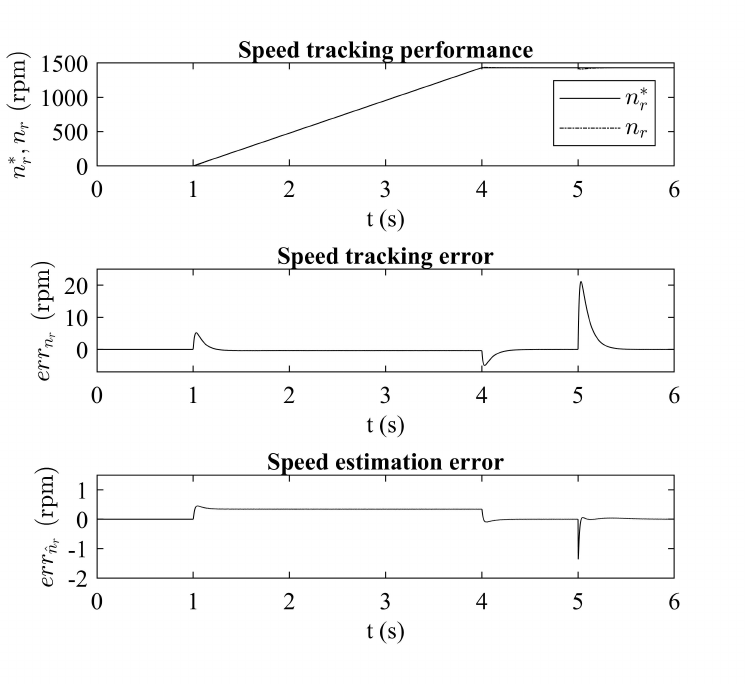
Figure 5. Speed tracking